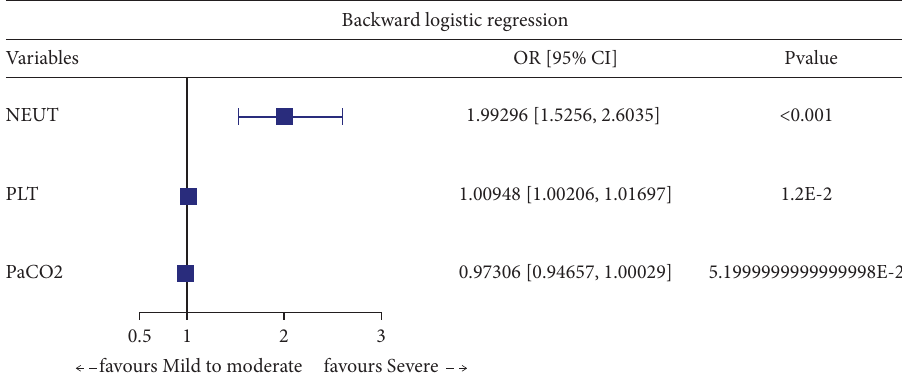
Figure 4: Multivariate logistic regression analysis with backward